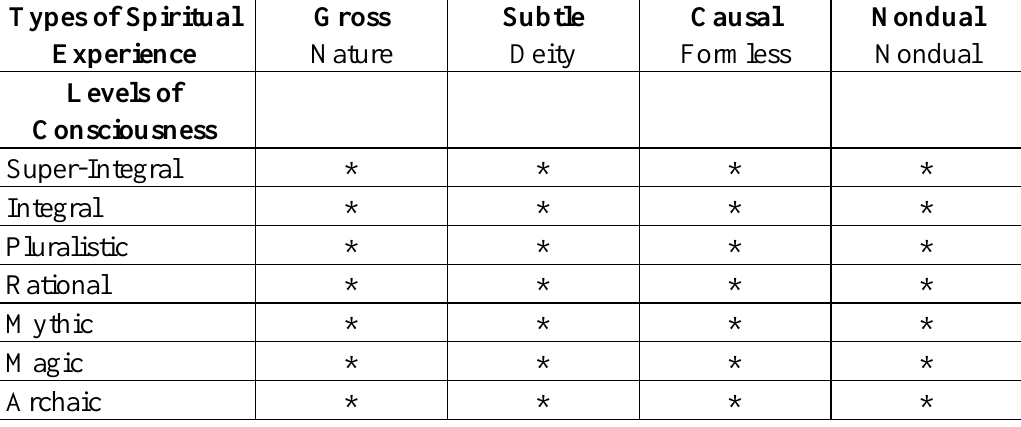
Table 1. Adapted from Wilber-Combs Lattice